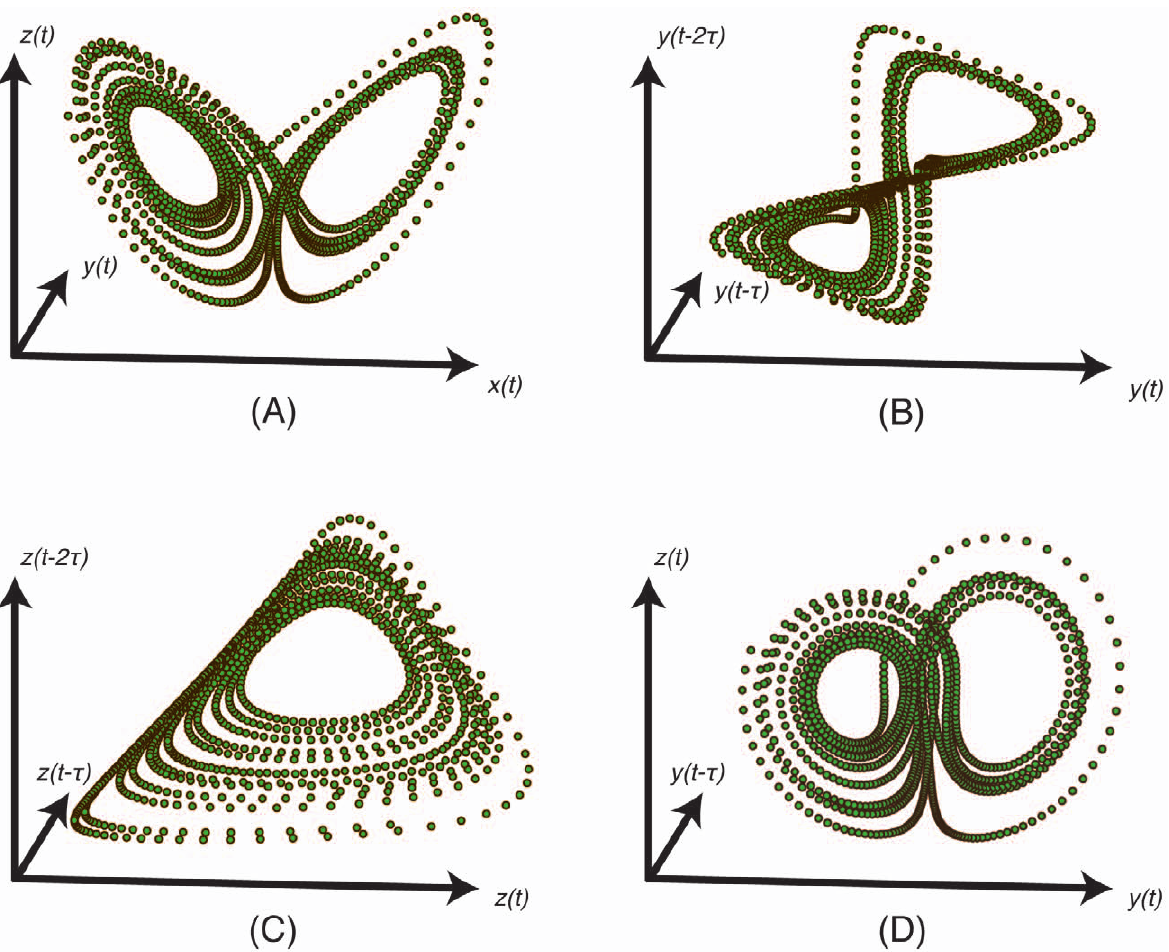
Figure 1. Lorenz attractor with three shadow manifolds. The Lorenz attractor [37] is shown with three shadow manifolds created from lag- coordinate transformations. The typical parameters were used: s ~ 10 , r ~ 28 , and b ~ 8 = 3 , giving the three coupled equations as _ xx ~ 10( y { x ) , _ yy ~ 28 x { xz { y , and _ zz ~ xy { (8 = 3) z . The solution was computed using a fourth order Runge-Kutta method with a time step of d t ~ 0 : 01 , and the time lag used to create the shadow manifolds was t ~ 8 d t ~ 0 : 08 . (A) The trajectory shown in the x , y , and z coordinates of the original system reveals a two-lobed manifold. (B) A univariate transformation using time lags of the y -coordinate, W ~ ( y ( t ), y ( t { t ), y ( t { 2 t )) , preserves this two-lobed structure (and other topological properties), verifying Takens’ theorem. (C) A univariate transformation using time lags of the z -coordinate, W ~ ( z ( t ), z ( t { t ), z ( t { 2 t )) , does not preserve the two-lobed structure. Local neighborhoods of the original attractor are, however, preserved. Thus, though this mapping violates a genericity assumption of the original theorem and is not an embedding, it is an immersion of the original manifold. (D) A multivariate transformation using both the y - and z -coordinates, W ~ ( y ( t ), y ( t { t ), z ( t )) , fulfills the assumptions of Theorems 2 and 7. As predicted, it also preserves the two-lobed structure of the Lorenz and is a valid